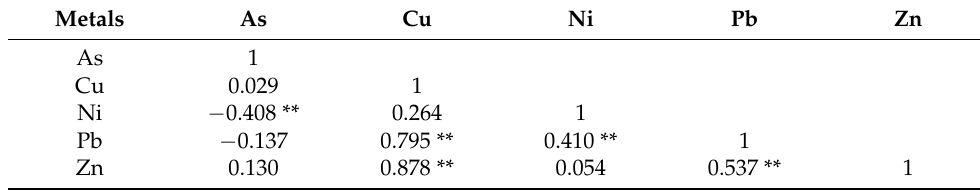
Table 5. Pearson’s correlation matrix for selected toxic metals in the surface